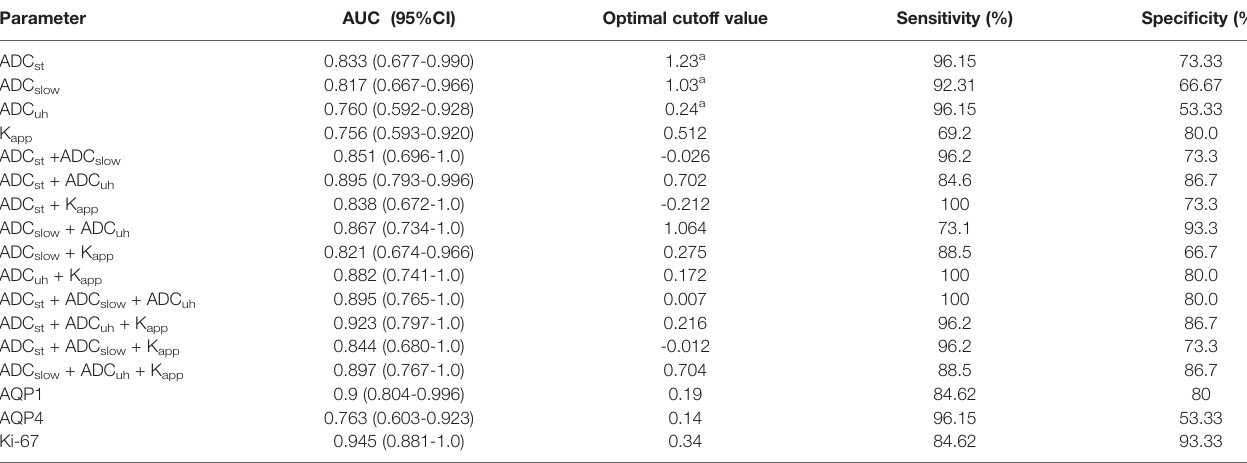
TABLE 3 | The performance of diffusion weighted imaging derived imaging metrics at tumor center and histological biomarkers in differentiating low- and high-grade gliomas. Parameter